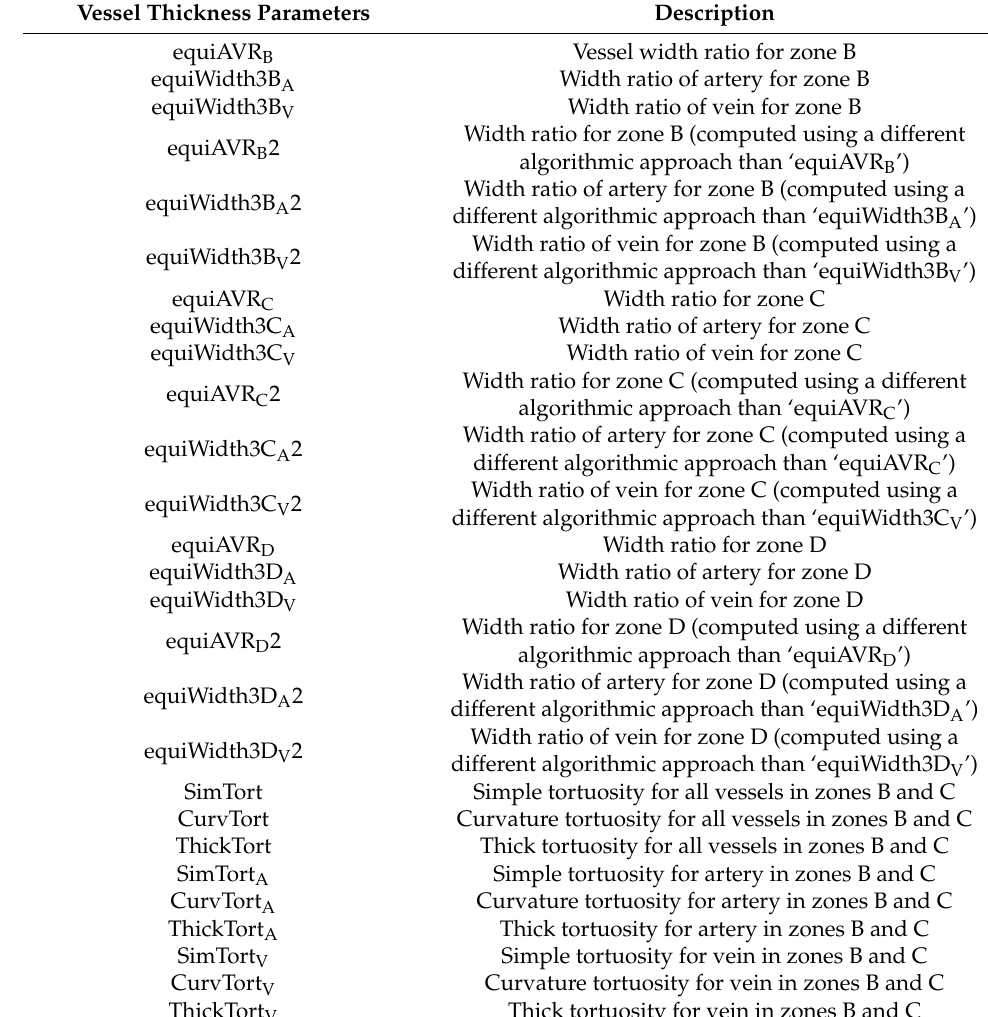
Table 1. Vessel parameters generated by VASP that are used in this